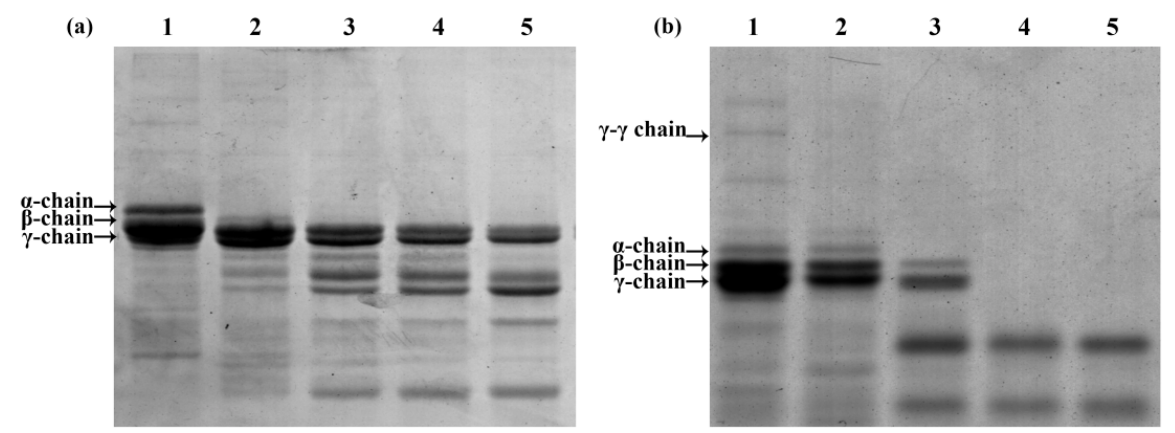
Figure 4. Determination of time-dependent degradation of fibrin and fibrinogen (FIB) of Velefibrinase. The degradation pattern of ( a ) FIB and ( b ) fibrin by Velefibrinase is shown using 12% SDS-PAGE. Lanes 1–5 are degradation products incubated (0.02 M PBS, pH 7.2, 37 ◦ C) after of 0, 20, 40, 60, and 80 min, respectively. Table 4. The effect of Velefibrinase on the lysis of blood